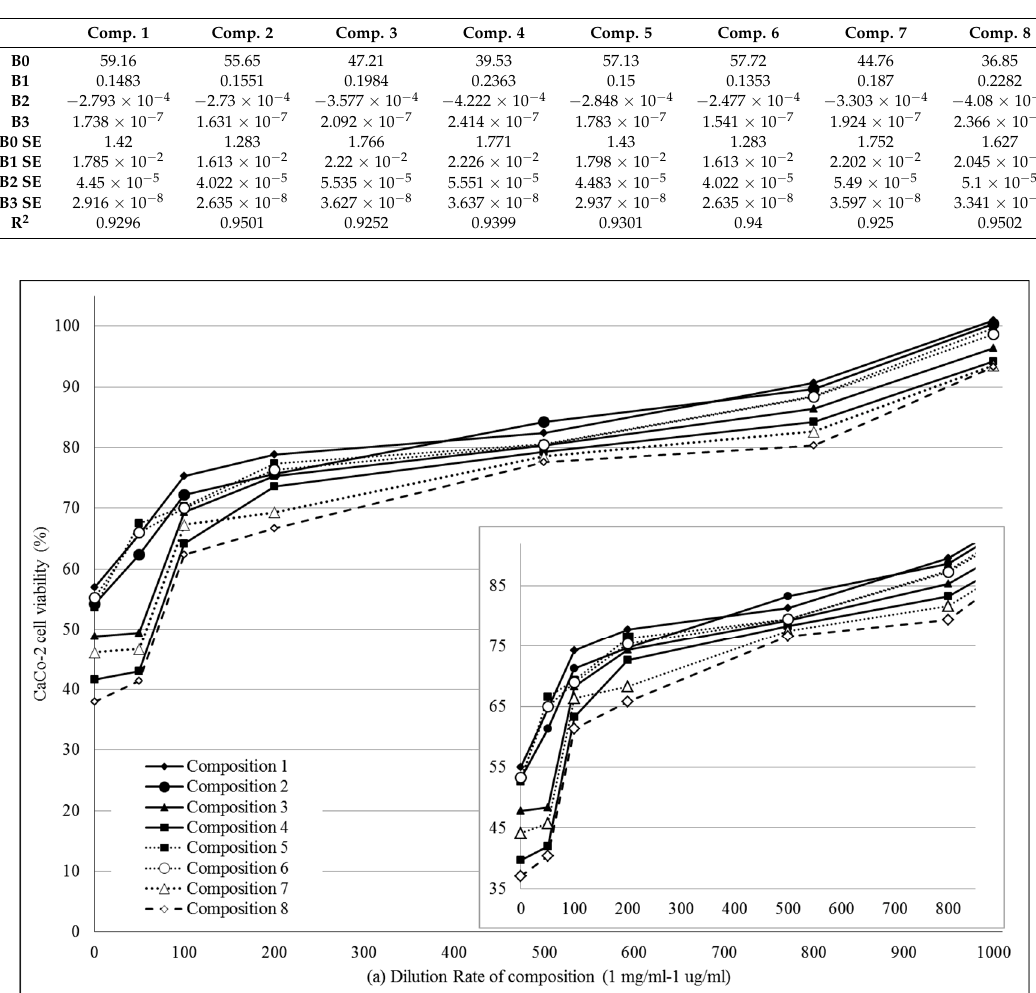
Table 3. Regression parameters using cuboid polynomial equation and goodness of fit data for the cell viability evaluation following MTT (3-(4,5-dimethylthiazol-2-yl)-2,5-diphenyltetrazolium bromide) assay on Caco-2 cells treated with compositions 1 – 8 (see: Figure 3, Panel B). SE = Standard Error. (Comp. = Composition).